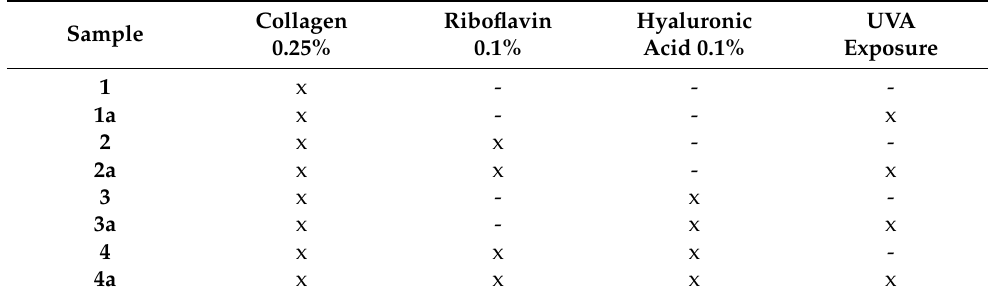
Table 1. The composition of collagen samples investigated in this study, in the absence and in the presence of UVA